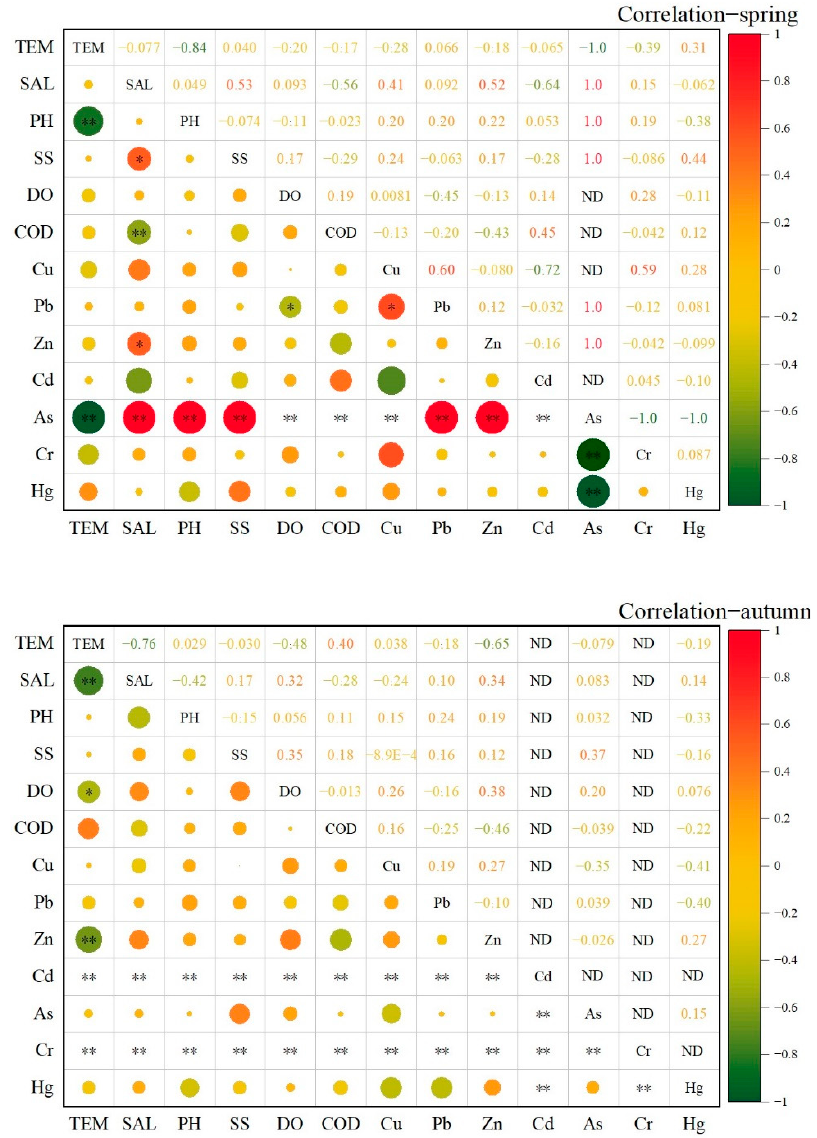
Figure 6. The correlational analysis of heavy metals in the seawater of coastal Hong Kong (* p < 0.05; ** p < 0.01).